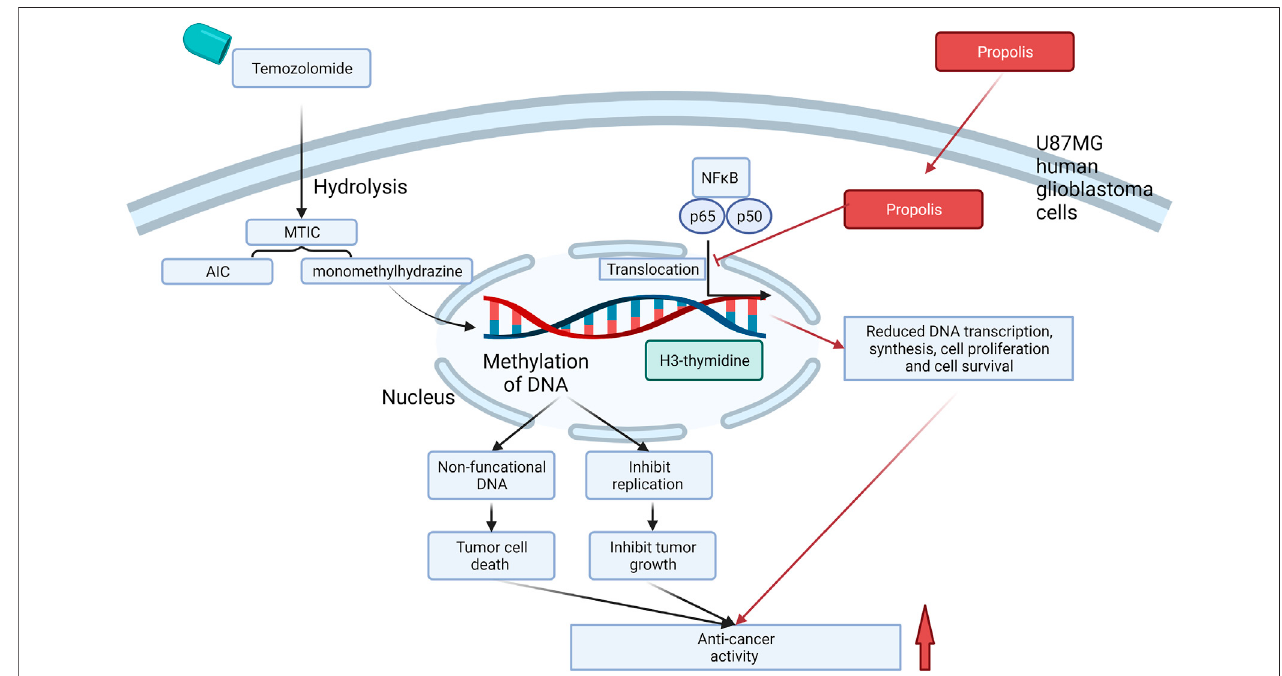
FIGURE 2 | Interactions of TMZ with propolis at the molecular level, which led to enhanced cell death, in U87 MG human glioblastoma cells. Red arrow represents the molecular actions of propolis, and black arrow represents the molecular actions of TMZ. The action of TMZ that caused cell death was attributed to its metabolite- inducedmethylationofDNA,whereaspropolismaystrengthentheanti-canceractivity via inhibitingNF- κ Bsignalingmediatedcellproliferationandsurvival.MTICandAIC are the metabolites of TMZ after hydrolysis. MIC, 3-methyl-(triazen-1-yl) imidazole-4-carboxamide; AIC, 5-aminoimidazole-4-carboxamide.